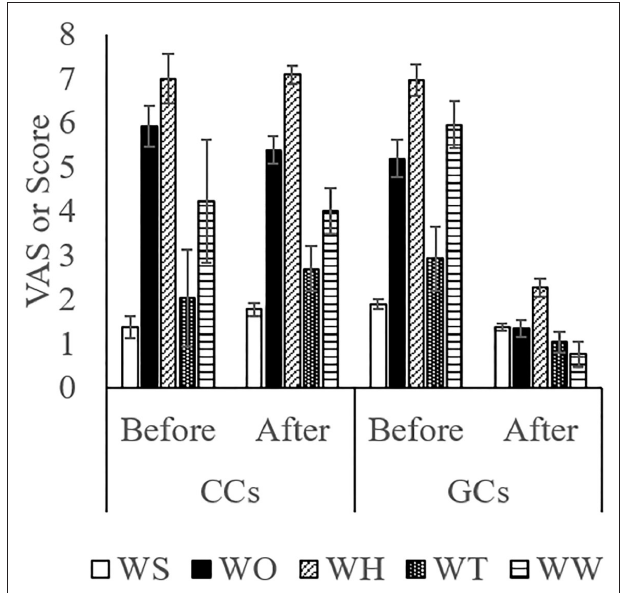
FIGURE 2 | Temperament while moving to the body weight scale and during weighing in GCs and CCs. The horizontal axis shows the temperament before and after the start of grazing. Data are presented as the means ± SEM. WS, The scoring of resistance during movement to the body weight scale; WO, The VAS score for overall movement; WH, The visual analog scale (VAS) score for head movement; WT, The VAS score for tail flicking; WW, The VAS score for